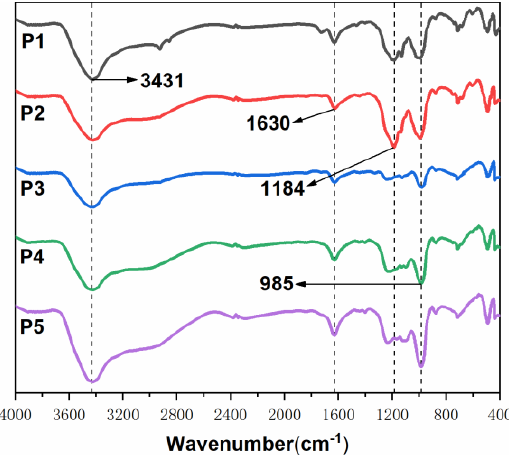
Figure 13. FTIR spectra of residual carbon after cone test.